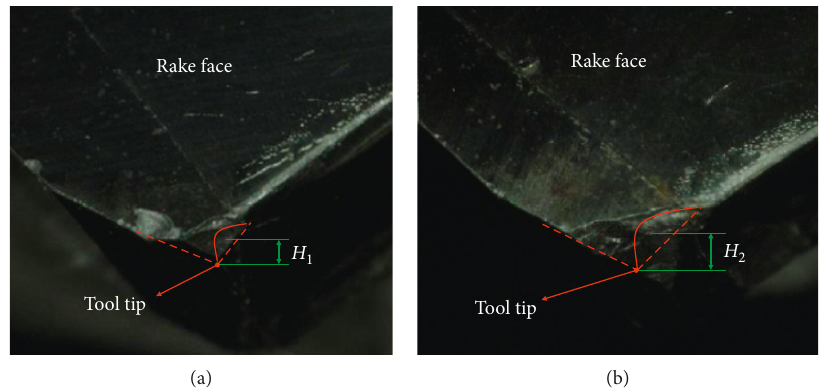
Figure 19: Tool damage under different cutting depths (adapted from ref. [29]). (a) Smaller cutting depth. (b) Larger cutting depth.